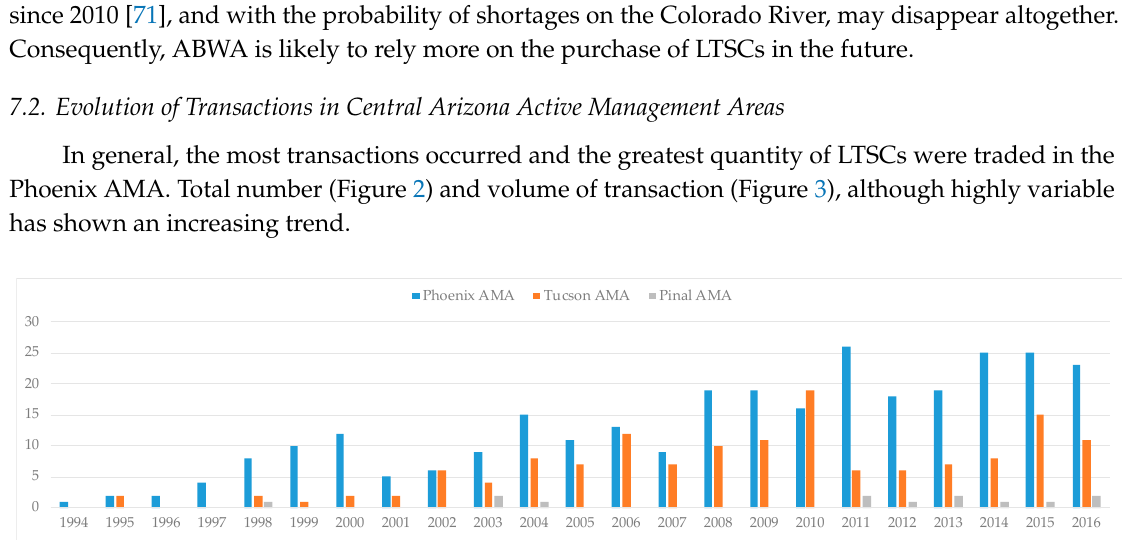
Figure 2. Number of long-term storage credits transactions in Central Arizona AMAs, from 1994 to 2016.